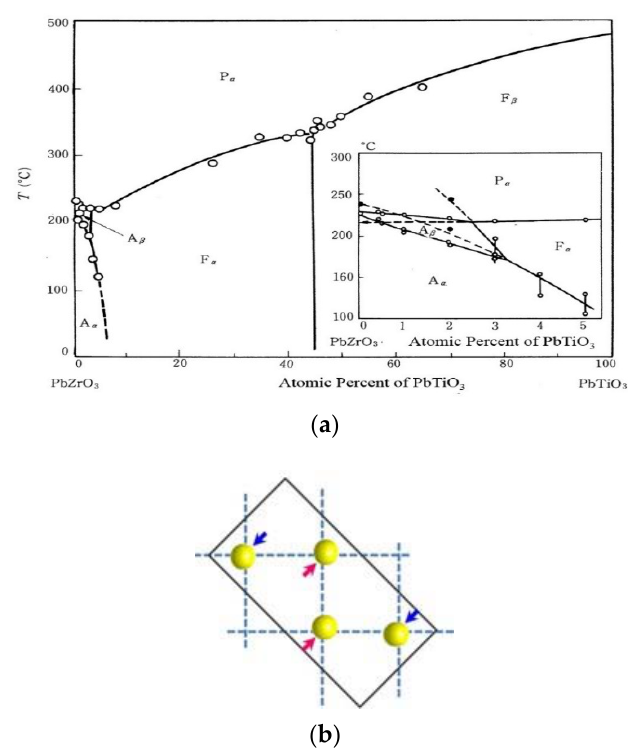
Figure 5. ( a ) PZT system phase diagram with a particular interest in the PZ rich region; and ( b ) Pb 2+ ionic shift in a PZ unit cell to visualize the antipolar structure